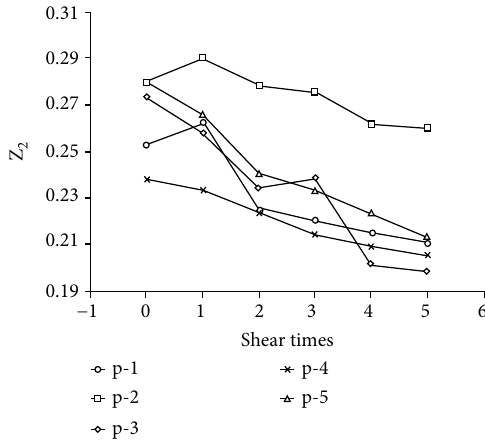
Figure 7: Root-mean-square values of discontinuities.